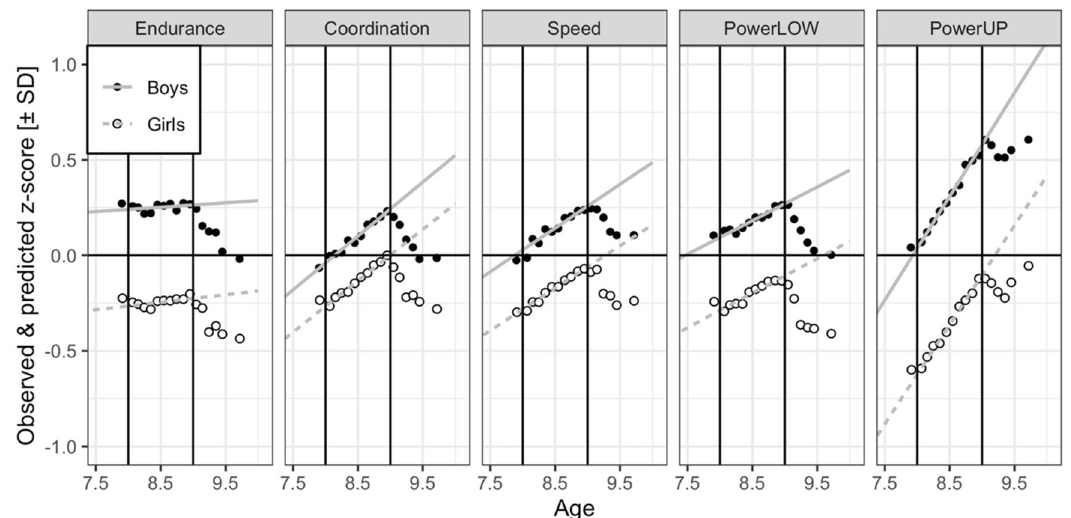
Figure 1. Observed z-scores for physical fitness development for boys (closed circles) and girls (open circles) aged 7.00–10.0 years. The lines represent the predicted z-scores for physical fitness development for boys (grey line) and girls (dashed grey line). Data were z-transformed. Endurance = cardiorespiratory endurance (i.e., 6-min-run test), Coordination = star-run test, Speed = 20-m linear sprint test, PowerLOW = lower limbs muscle power (i.e., standing long jump test), PowerUP = upper limbs muscle power (i.e., ball-push test). Note that delta z-scores for younger-than-keyage boys and girls were aggregated over 7.00–7.99 years and that delta z-scores for older-than-keyage boys and girls were aggregated over 9.50–9.99 years. Points are binned observed child means. Coordination and speed times were converted from seconds to meters/seconds (i.e., pace scores; star-run test = 50.912 [m]/time [s]; 20-m linear sprint test = 20 [m]/time [s]). These transformations have the advantage that a large value is indicative of better physical fitness and that they remove skew in the